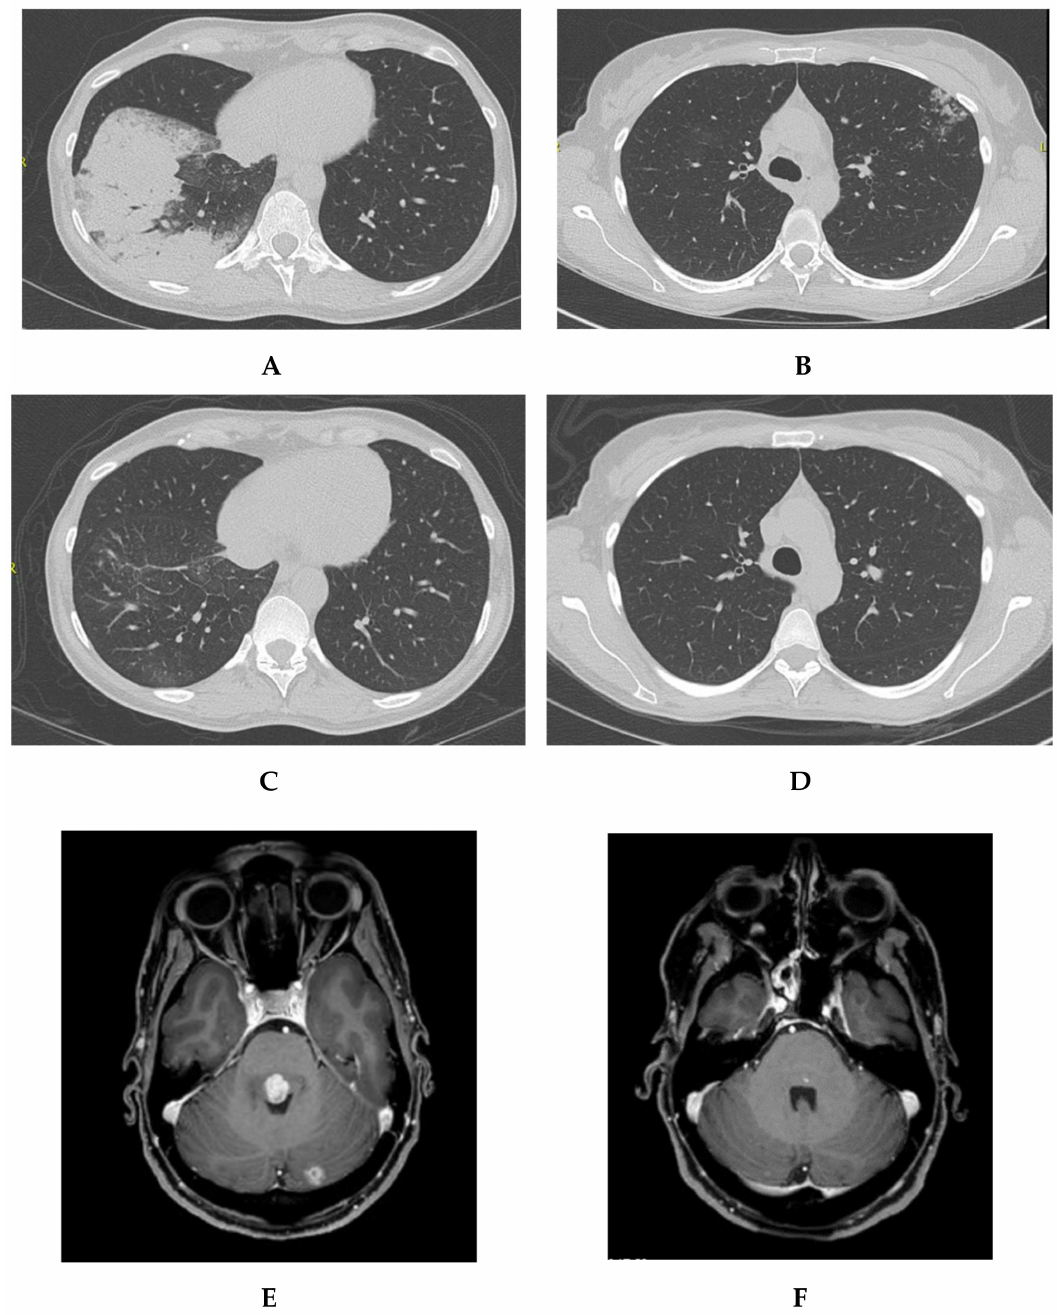
Figure 3. Disease Response on Alectinib in patient 3. Pictures ( A , B ): November 2019. Pictures ( C , D ): same localization as A and B, respectively, in January 2020. Pictures ( E , F ): Significant response in brain lesions on Alectinib in patient 3. ( E ) November 2019. ( F ) December